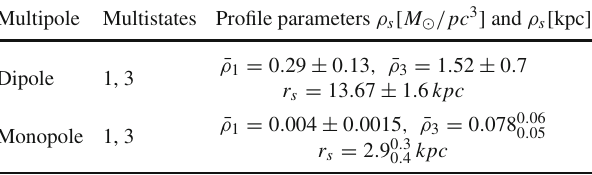
Table 1 Estimates for the parameters of the multi-states yielding to the density profiles of dark matter with dipole and monopole spatial distributions